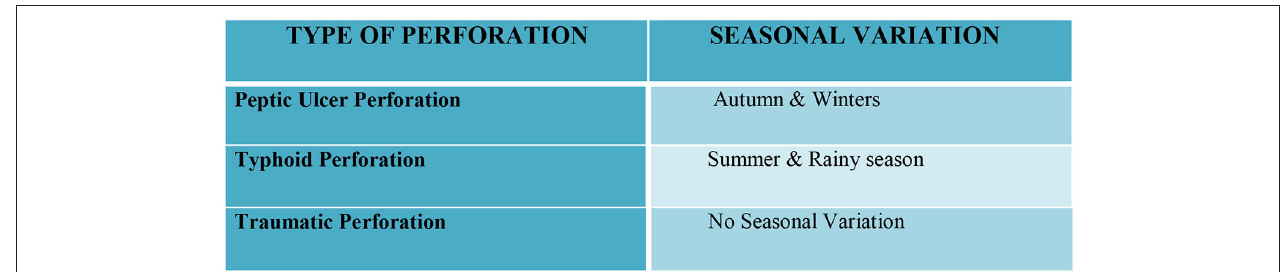
FIGURE 2 | Seasonal predominance of different